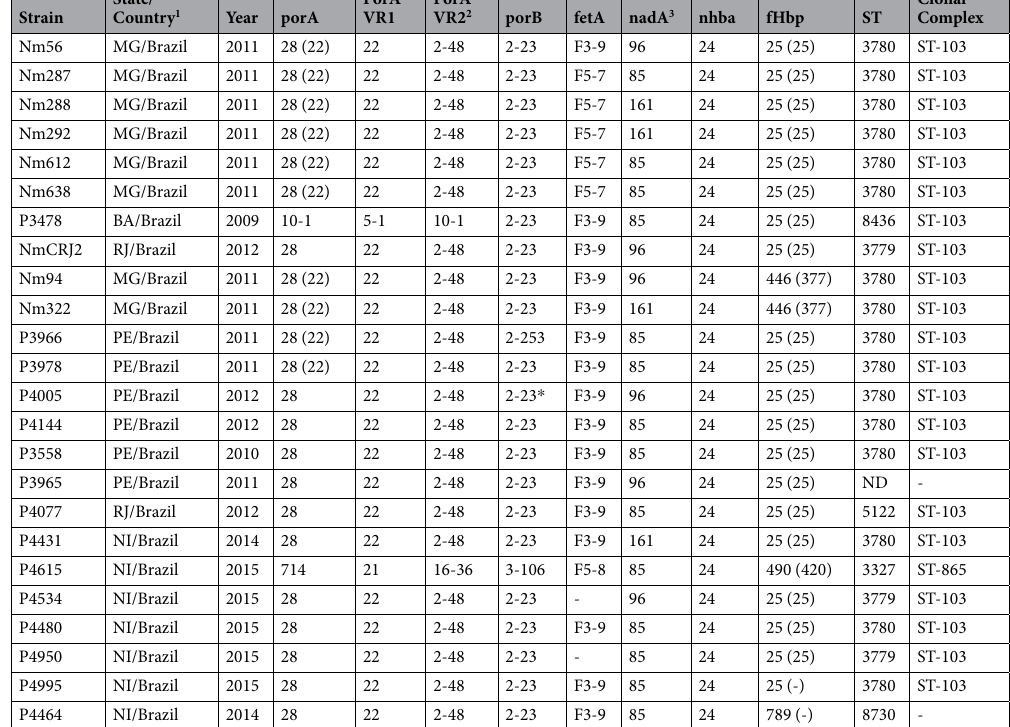
Table 1. MenC strains from Brazil sequenced in this study. The antigen-encoding gene profiles, sequence type and clonal complex designations were defined based on Neisseria pubMLST database (http://pubmlst.org/ neisseria/). 1 MG, Minas Gerais; BA, Bahia; RJ, Rio de Janeiro; PE, Pernambuco; NI, not informed. 2 The 2-48 profile was defined by the closest match locus 3 nadA locus interrupted by insertion sequence (IS) element; the profile was defined by the closest match locus; -, not defined by PubMLST